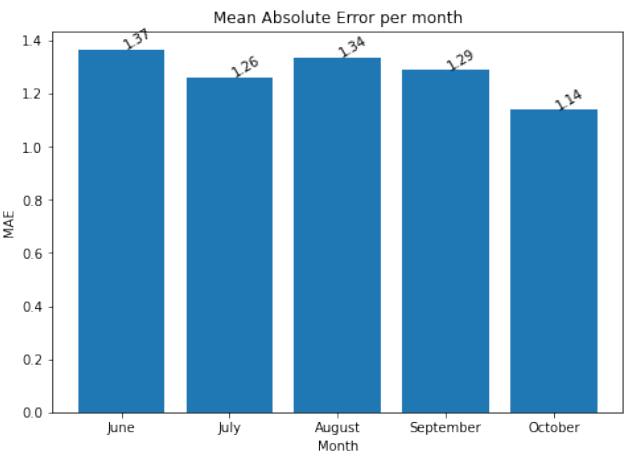
Figure 7. MAE per month of Culex Italy case using both EO and entomological